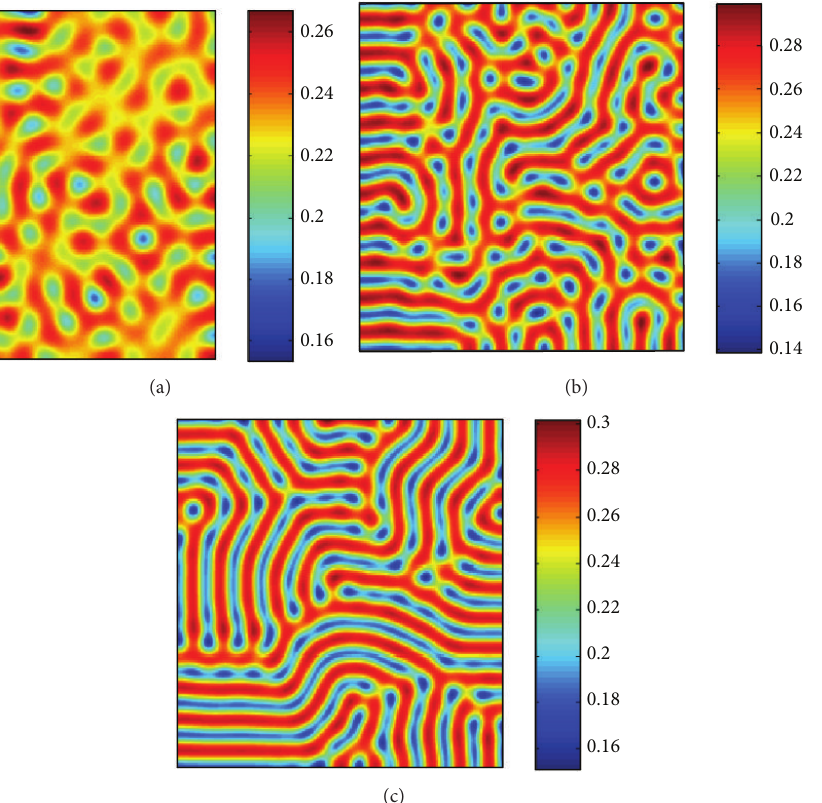
Figure 5: Snapshots of contour pictures of the time evolution of predator in system (3) when 𝑑 2 = 7 and 𝛿 𝐻 < 𝛿 = 0.4 < 𝛿 𝑇 : (a) 20000 iterations, (b) 40000 iterations, and (c) 200000